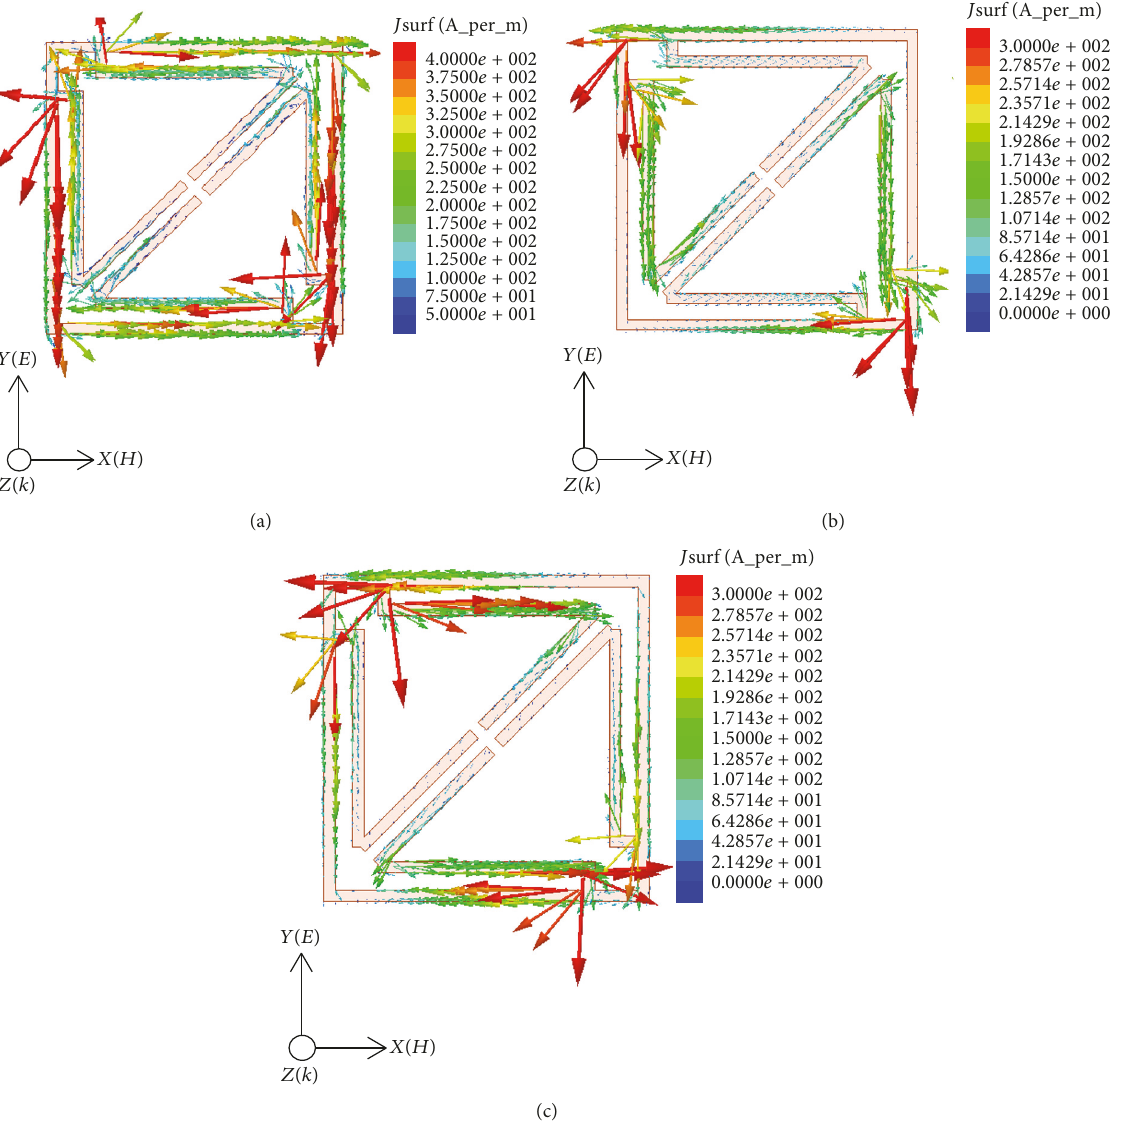
Figure 5: Surface current density 𝐽 𝑠 on the metallic patterns of TBEMR metamaterial at resonant frequencies (a) 𝑓 01 = 4.32 GHz, (b) 𝑓 02 = 7.55 GHz, and (c) 𝑓 = 9.76 . Note that red color indicates strong positive 03